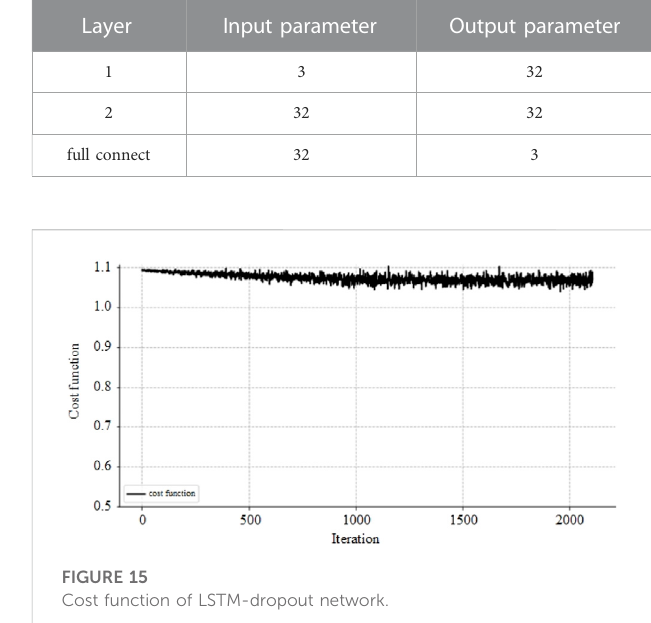
FIGURE 15 Cost function of LSTM-dropout network.